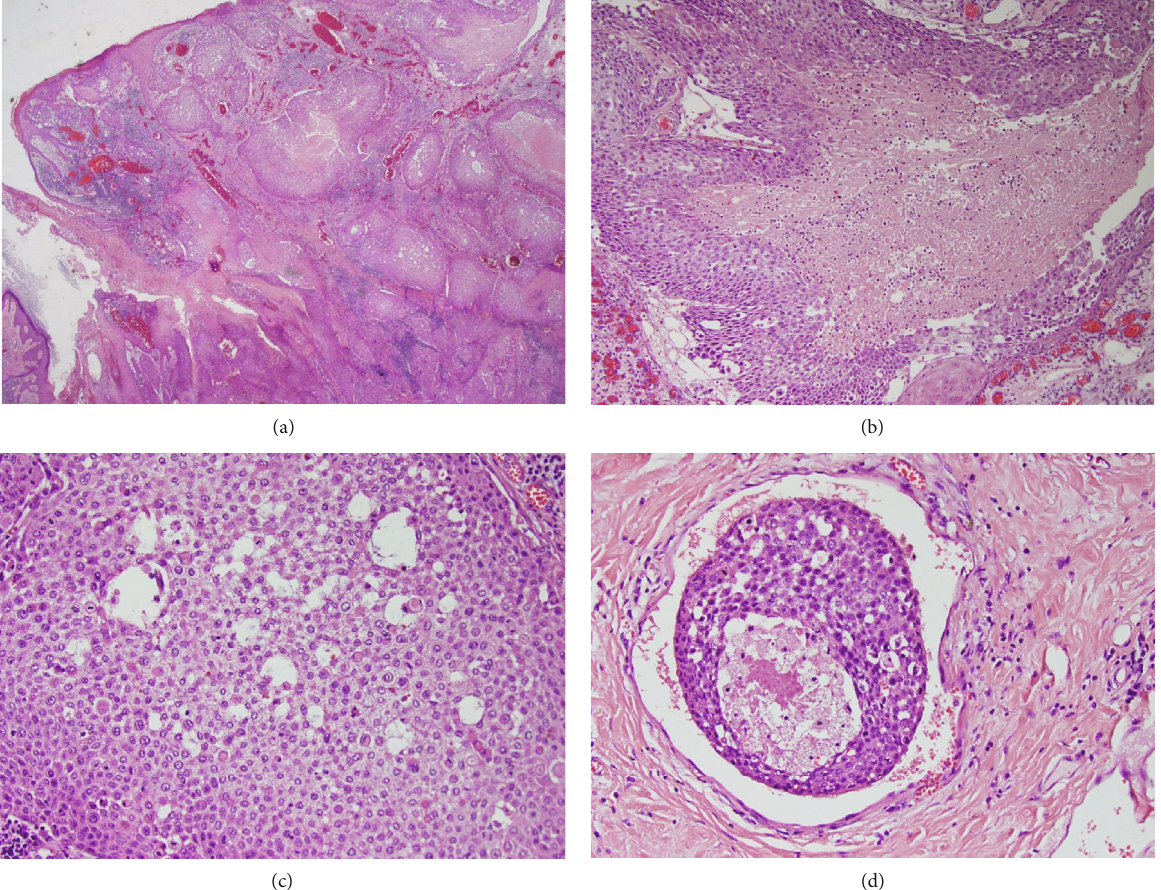
Figure 3: Tumour H&E sections: (a) skin-based carcinoma showing islands of in fi ltrating tumour ( × 40); (b) focus of central necrosis ( × 100); (c) cytoplasmic clearing within tumour islands with nuclear pleomorphism ( × 100); (d) focus of lymphovascular invasion ( ×